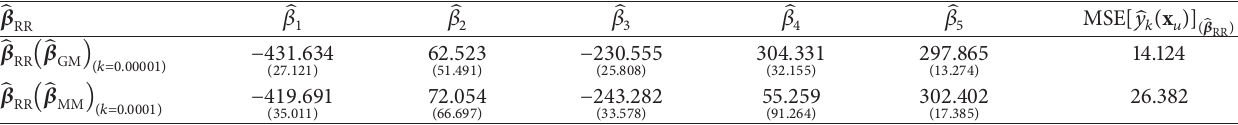
Table 5: The parameter estimates of the ridge-type robust